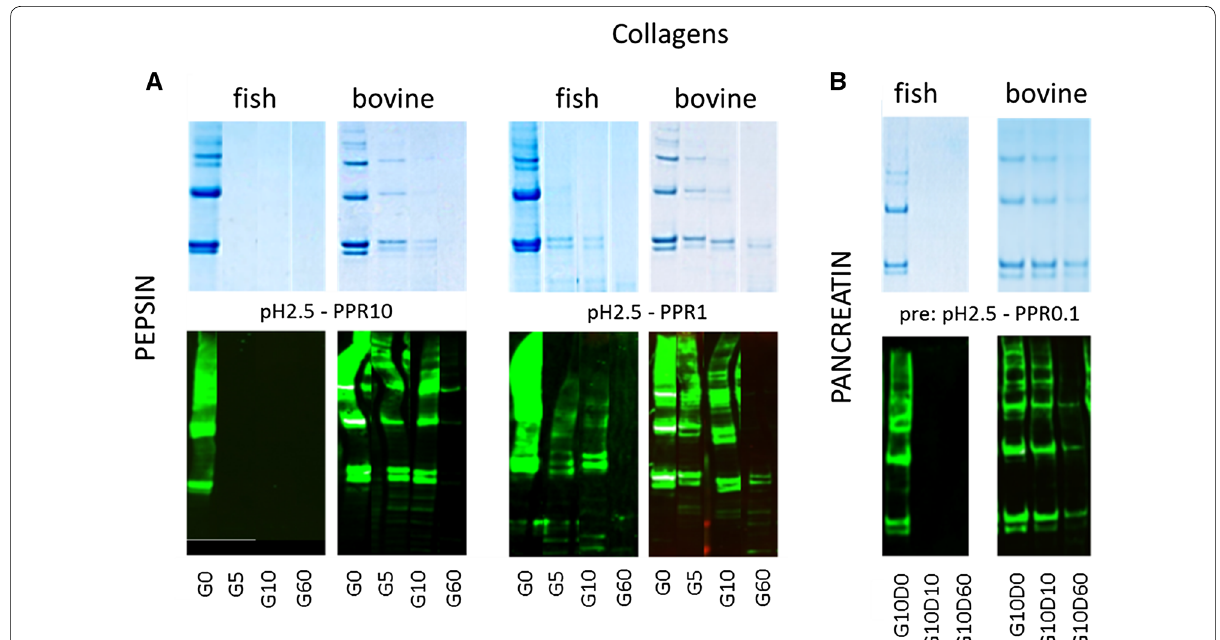
Fig. 5 Selected SDS‑PAGE and immunoblot samples are shown for both collagens from fish and beef. A Fish collagen is more resistant to pepsin than bovine collagen. B Fish collagen is highly susceptible to pancreatin whereas bovine is quite